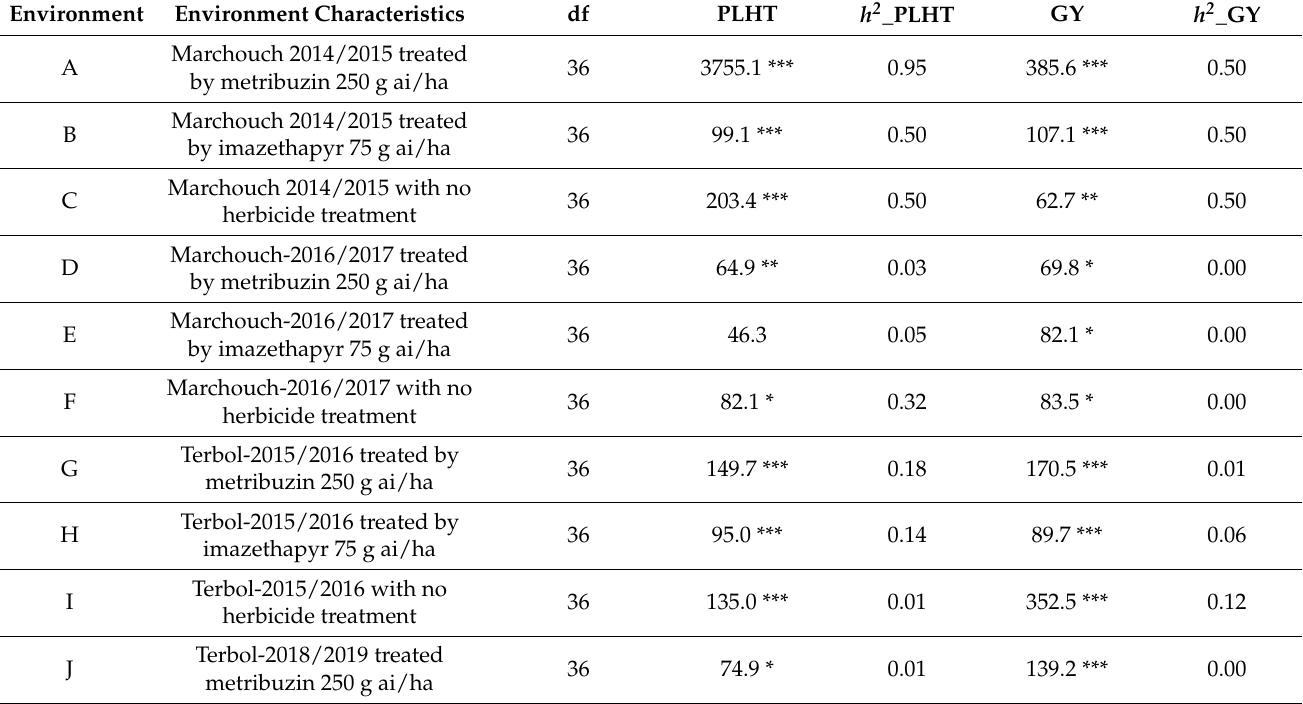
Df. degree of freedom, PLHT plant height, h 2 _PLHT narrow sense heritability of plant height, GY grain yield, h 2 _GY narrow sense heritability of grain yield, GE Genotype × Environment interac- tion, ND. no data, * p < 0.05, ** p < 0.01, *** p < 0.001.